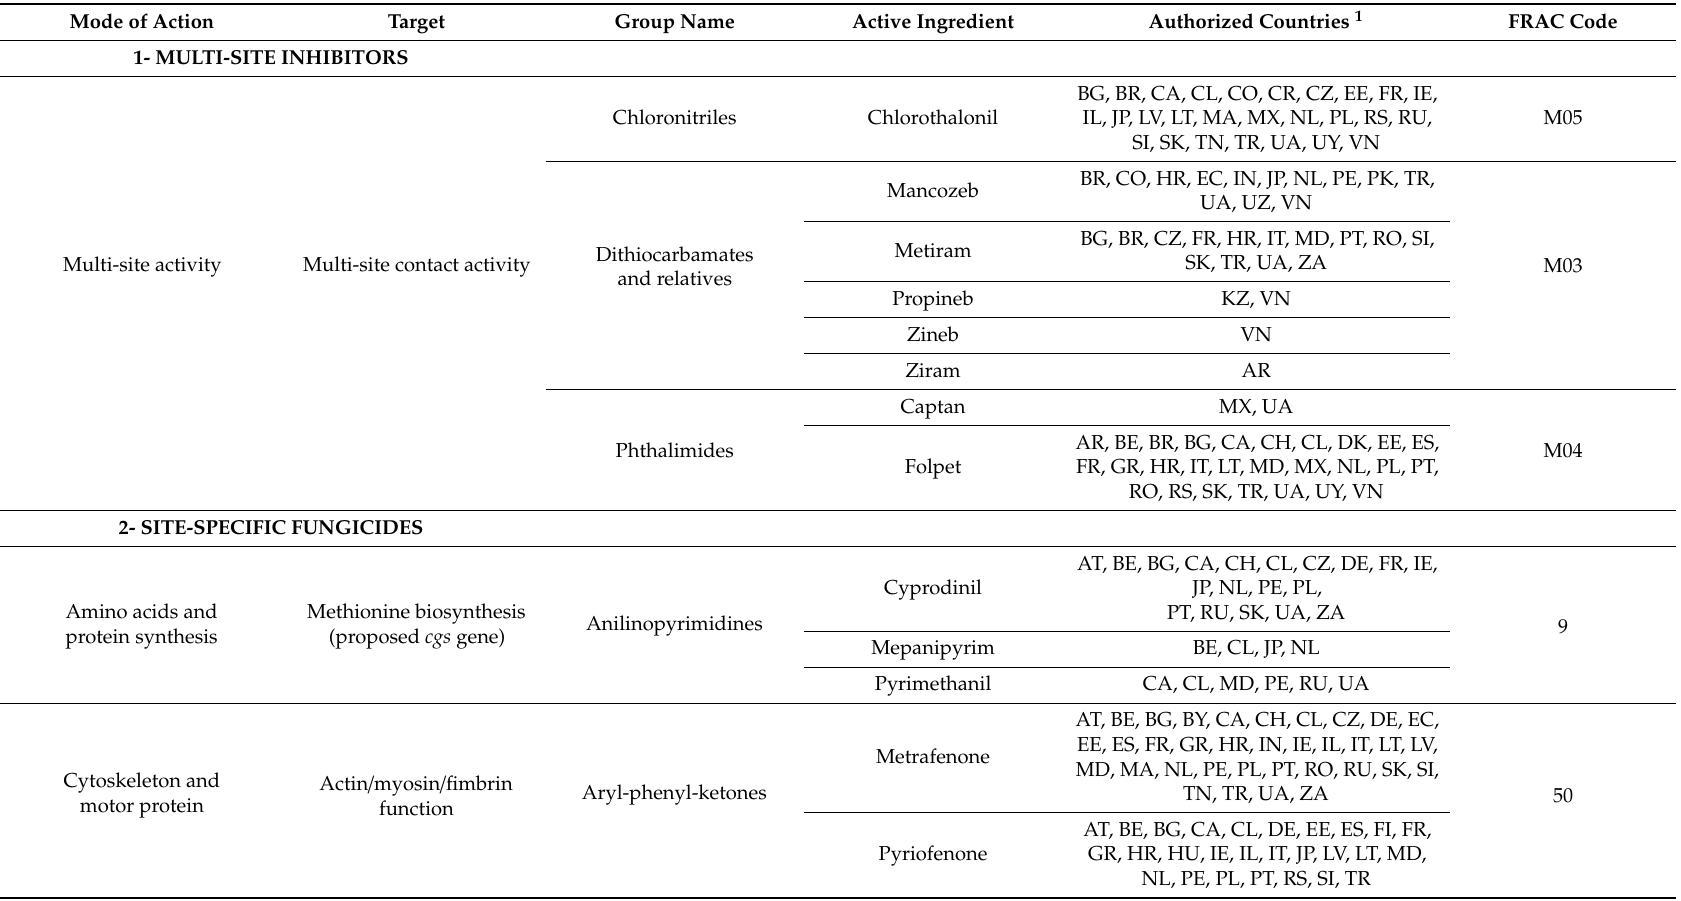
Table 1. Chemical classes of organic fungicides currently registered to control powdery mildew